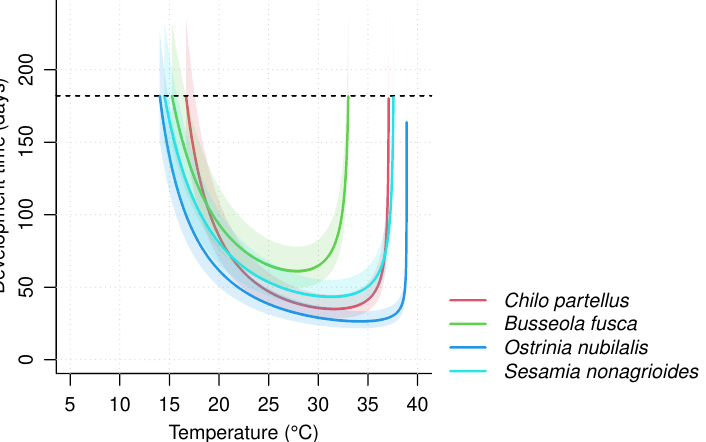
Figure 5. Impact of temperature on the total development time of Chilo partellus , Busseola fusca , Ostrinia nubilalis , and Sesamia nonagrioides . The development time was predicted for 5000 individuals by summing the inverse of development rates of each life stage. The development rates were drawn in a normal distribution with µ = τ j ( T ) and σ = 0.15 ∗ τ j ( T ) , where τ j ( T ) is the development rate predicted by the TPC of each life stage j . Mean development times as a function of temperature for the four species are represented. The 95% prediction interval is shown in transparency. The dashed line represents the 182-day limit for median development times that we fixed for characterizing the minimal and maximal temperature thresholds of each